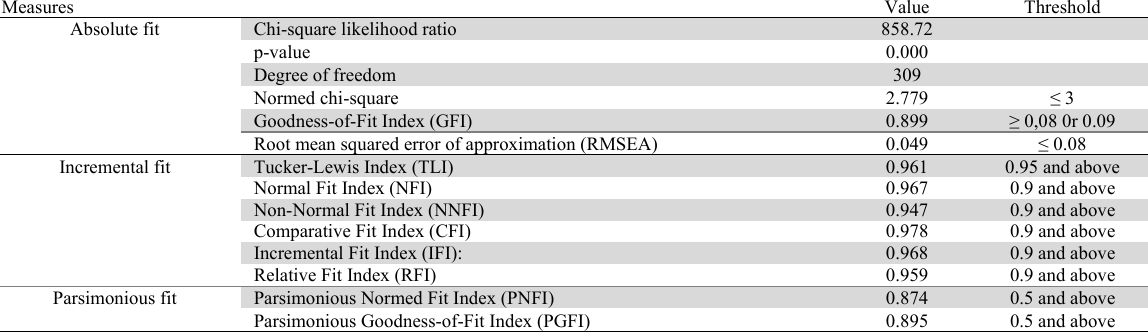
Structural Model Goodness-Of-Fit Indices